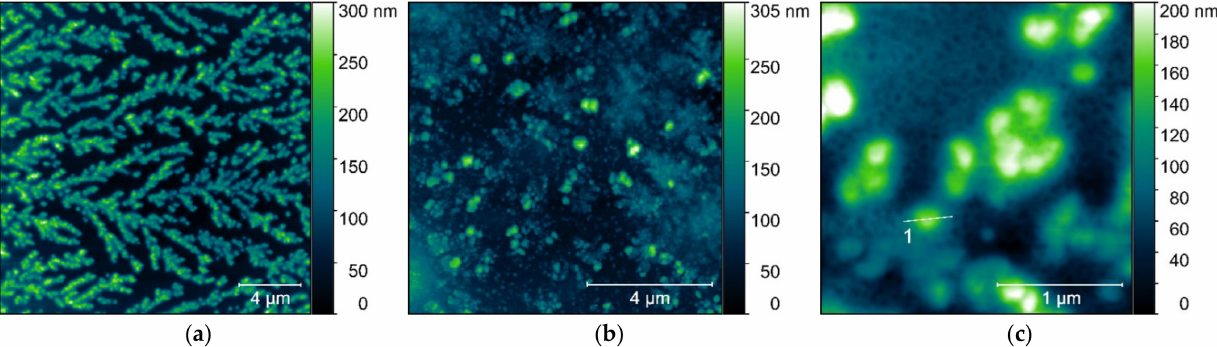
Figure 12. AFM images of ( a ) the high-molecular-weight DNA samples at 0.08 µ M and ( b , c ) 0.02 µ M concentration with marked cross-section, ( c ) for one of the visualized structures (see summarized cross-sections in Figure